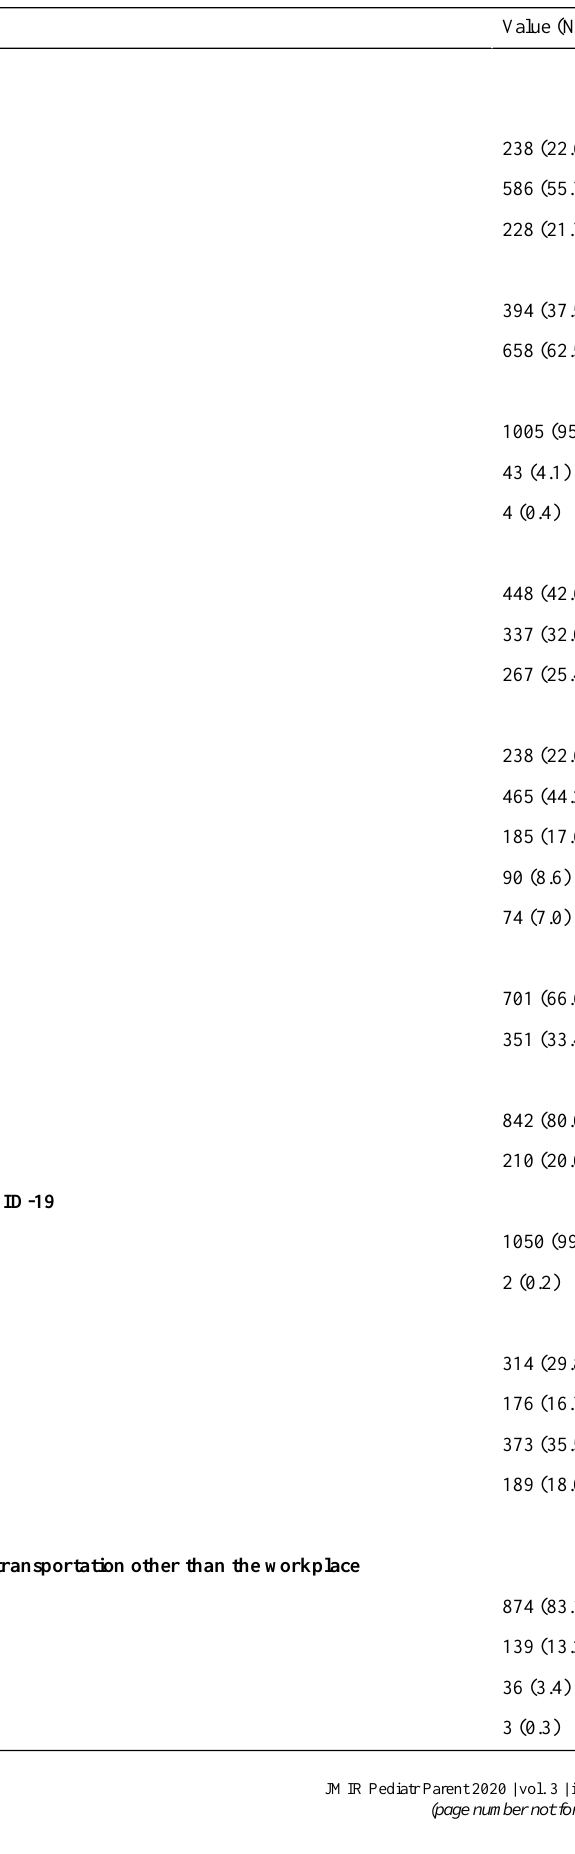
Table 1. Background characteristics of the